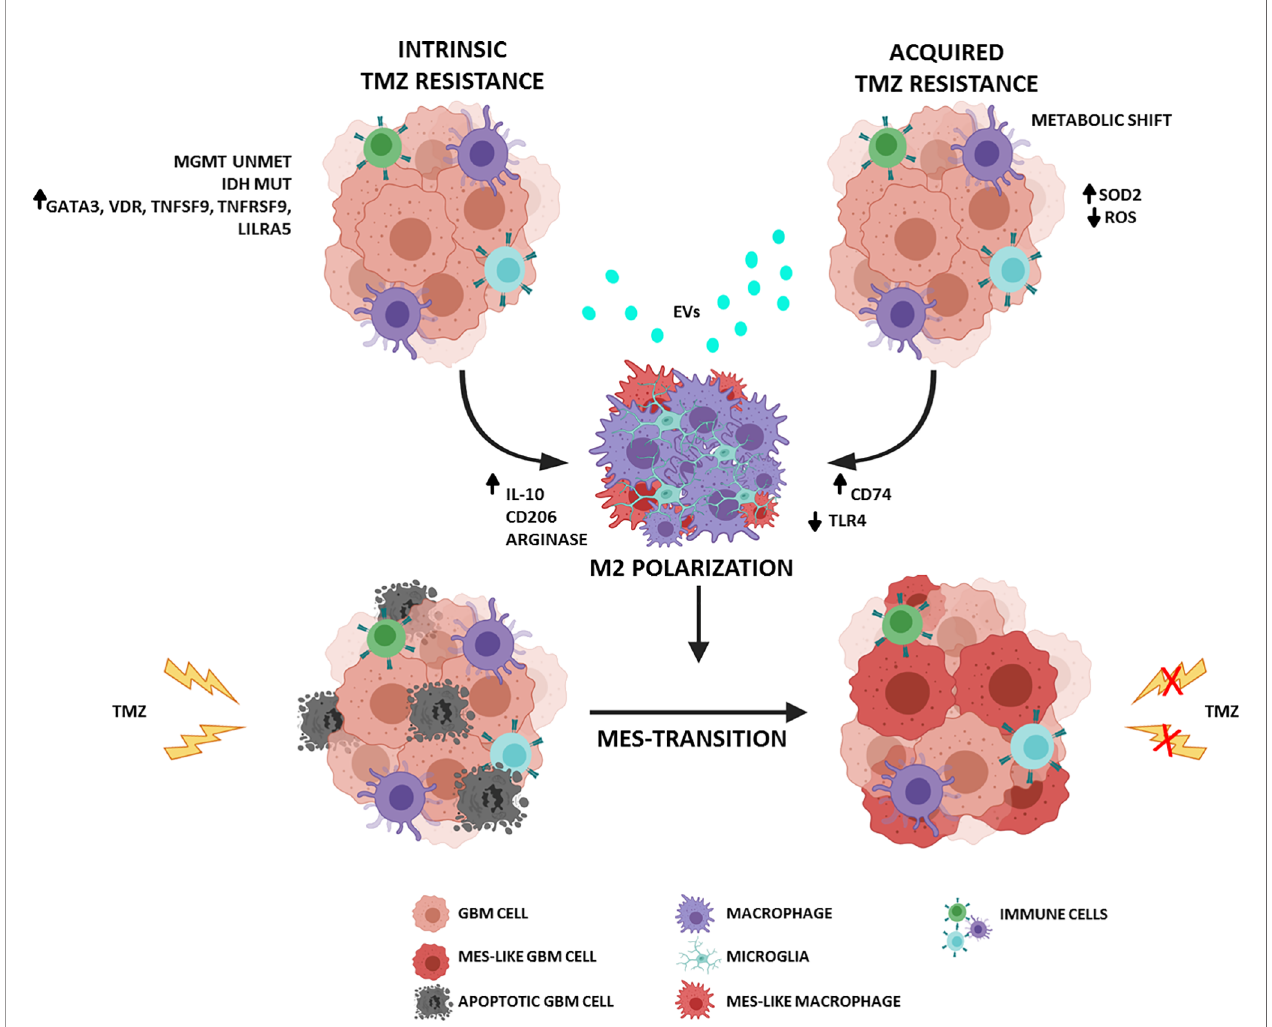
FIGURE 1 | Schematic representation of the interplay between GBM and ME in TMZ resistance. (Figure adapted from images created with